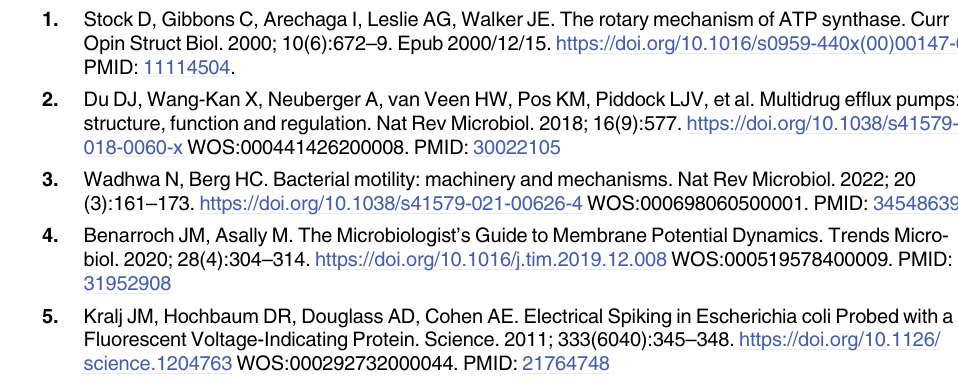
S1 Movie. Typical example of colony with blinking cell. Movie corresponds to Fig iiA in S1 Text. Δ t = 1